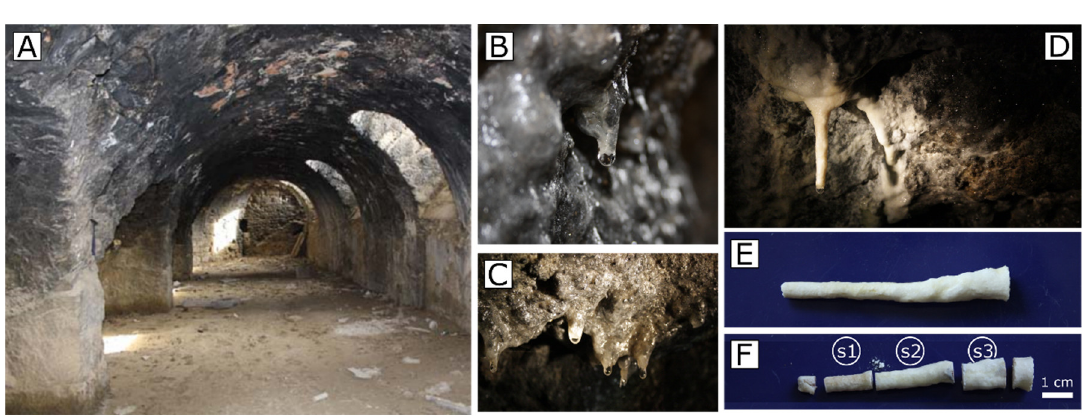
Figure 3. ( A ): general view of the studied storeroom. ( B ) and ( C ): details of different dripping points and initial stages of stalactites. ( D ) and ( E ): Studied stalactite. ( F ): samples obtained for mineralogical analysis (s1 and s3) and textural observations (s2).